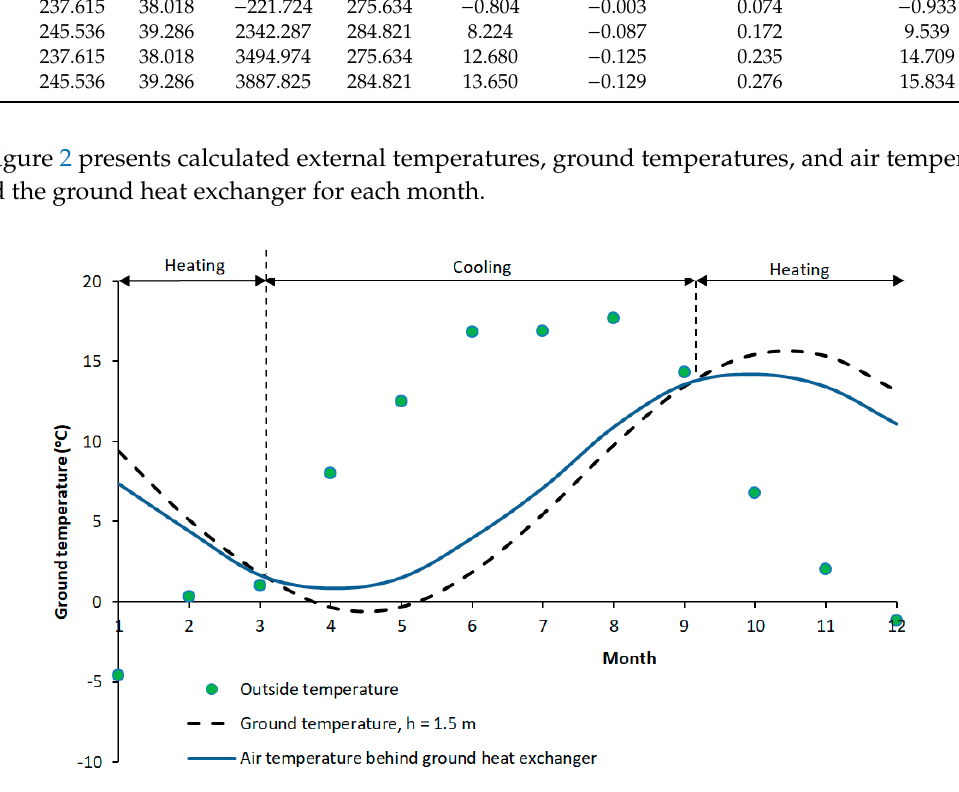
Figure 2. External temperatures, ground temperatures, and air temperatures behind the ground heat exchanger during the year.